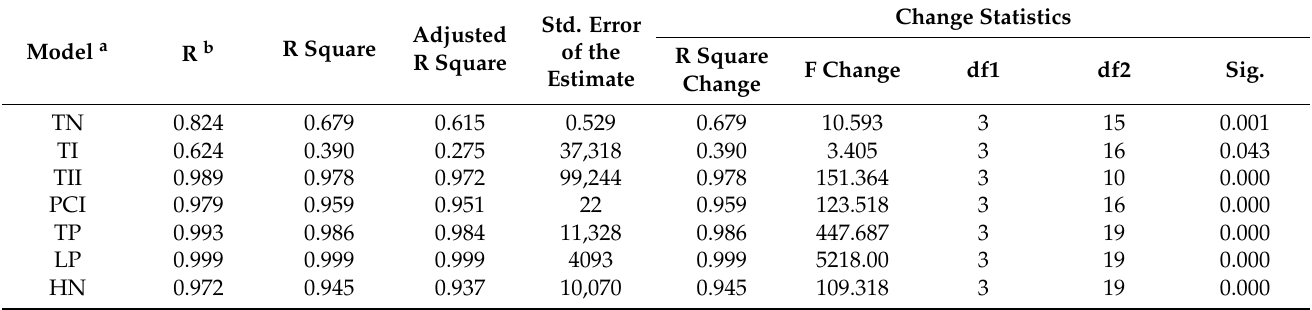
Table 3. SLR: Model